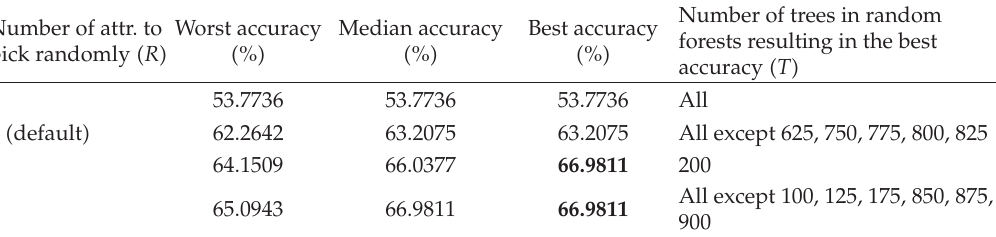
Table 8: The accuracy of random forests for the data set “Bridges.” Number of attr.